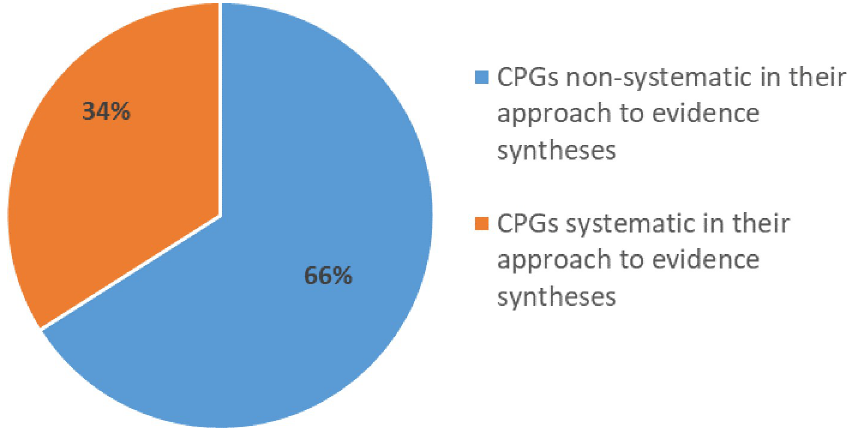
Fig 2. Systematic or non-systematic process used by guidelines in their approach to evidence synthesis (n = 50). To determine if a systematic process was used to gather, assess and synthesise evidence to inform